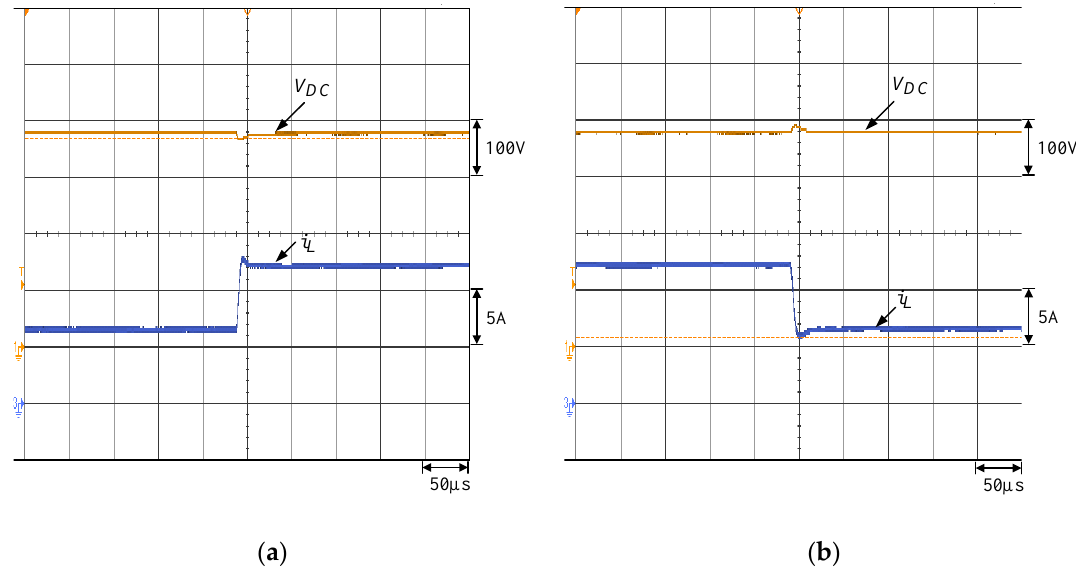
Figure 6. Inductance current and DC-link voltage under load variation: ( a ) 250 Ù → 135.7 Ù ; ( b ) 135.7 Ù → 250 Ù .